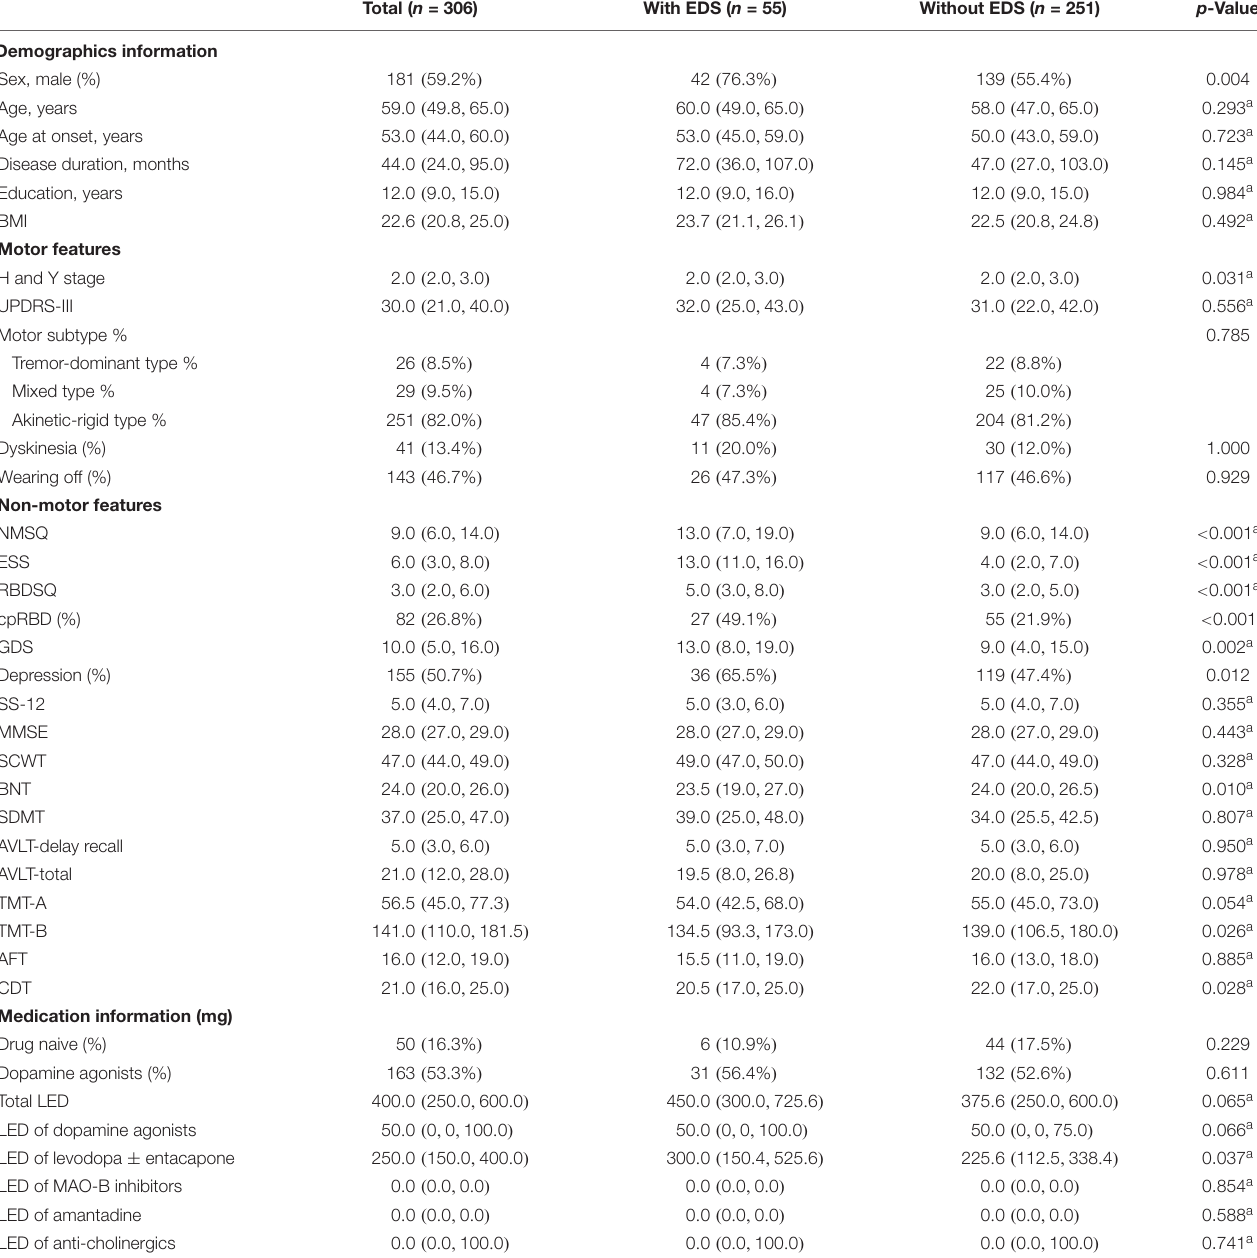
TABLE 1 | Demographic and clinical characteristics at